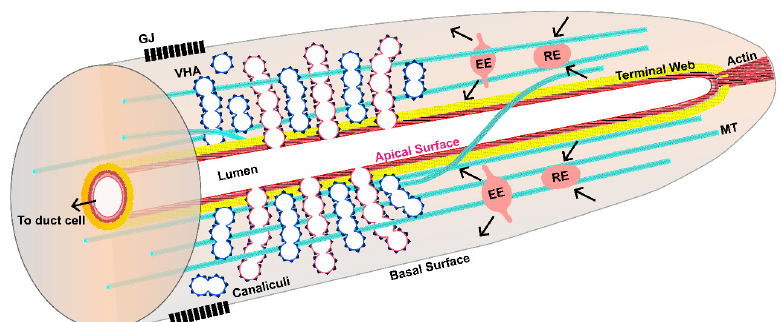
Figure 2. Diagram of canal section, showing subcellular morphology of lumen and canal tip. The apical membrane is shown in red surrounding the central lumen (in white), while the basal membrane is shown in grey. The apical surface is coated by actin filaments (thick red) and intermediate filaments (thick yellow) that together form the terminal web. Filaments extend to the distal terminus of the canal, presumably to help in canal extension. Small canalicular vesicles appear as separate vesicles (in blue) or connected to the lumen (in red) to form canaliculi. These vesicles are coated with vacuolar ATPase (VHA, black spikes on vesicles). Microtubules (cyan) extend along the length of the canal, interspersed with and outside the canaliculi. Some microtubules appear helically wound around the lumen. Early endosomes (EE) and recycling endosomes (RE) move along the canal length (See Supplementary Video S1). Gap junctions (black) connect the canal cytoplasm to neighboring